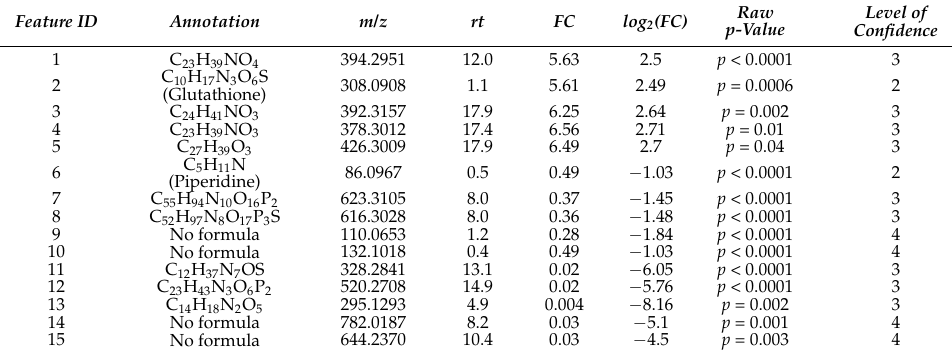
Figure 3. The impact of tomato root colonization by Rhizophagus irregularis on the gut metabolome of Manduca sexta larvae. ( A ) Two-dimensional principal component analysis (PCA) scores plot of M. sexta gut samples. ( B ) Significant metabolomic features annotated for the M. sexta gut samples. Manduca sexta larvae were fed for three weeks on leaves of tomato plants that were non-inoculated or root-inoculated with R. irregularis . In ( B ), the volcano plot displays fold change threshold ( x -axis) of 2 and t -test threshold ( y -axis) of 0.05. The purple circles represent features above the threshold. Both fold changes and p -values are log-transformed. The metabolomic features that showed the highest increase for the larvae reared on non-inoculated plants are found towards the right side of the volcano plot. The metabolomic features that showed the highest increase for the larvae reared on R. irregularis -inoculated plants are found towards the left side of the volcano plot. The most statistically significant metabolomic features for both treatments are found towards the top of the volcano plot. Table 2. The most significant metabolomic features annotated for the gut samples of Manduca sexta larvae fed for three weeks on leaves of tomato plants non-inoculated and root-inoculated with Rhizophagus irregularis . The feature number corresponds to the features given in Figure 3B, which are given by their corresponding mass to charge ratio ( m / z ) and retention time (rt) in minutes. The fold change (FC) refers to the feature’s qToF intensity and was calculated on the basis of a volcano plot conducted for the non-inoculated and R. irregularis -inoculated larvae. The volcano plot was conducted with a fold change threshold ( x -axis) of 2 and t -test threshold ( y -axis) of 0.05. The level of confidence of the identification/annotation is given according to Malinowska and Viant